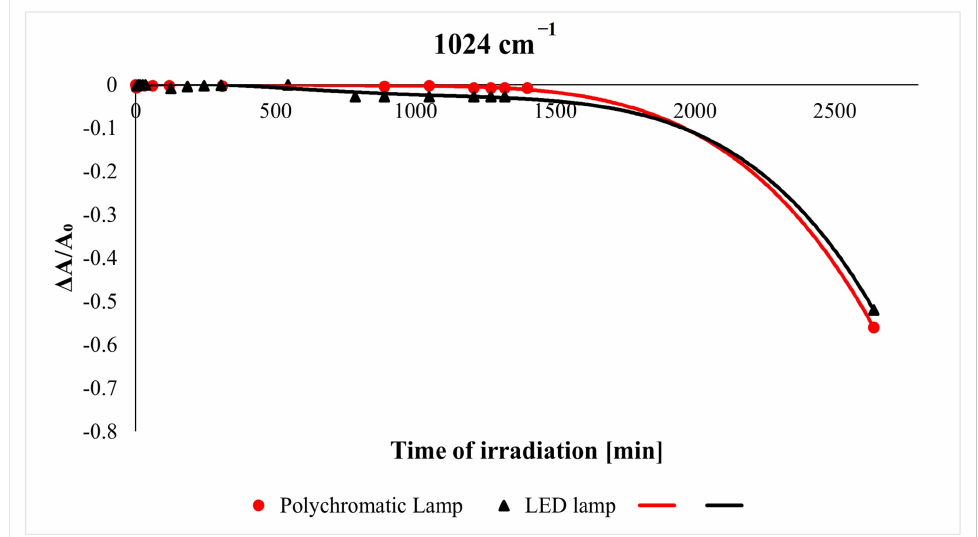
Figure 3. Changes in the relative absorbance of the selected bands of UV-irradiated levan film versus irradiation